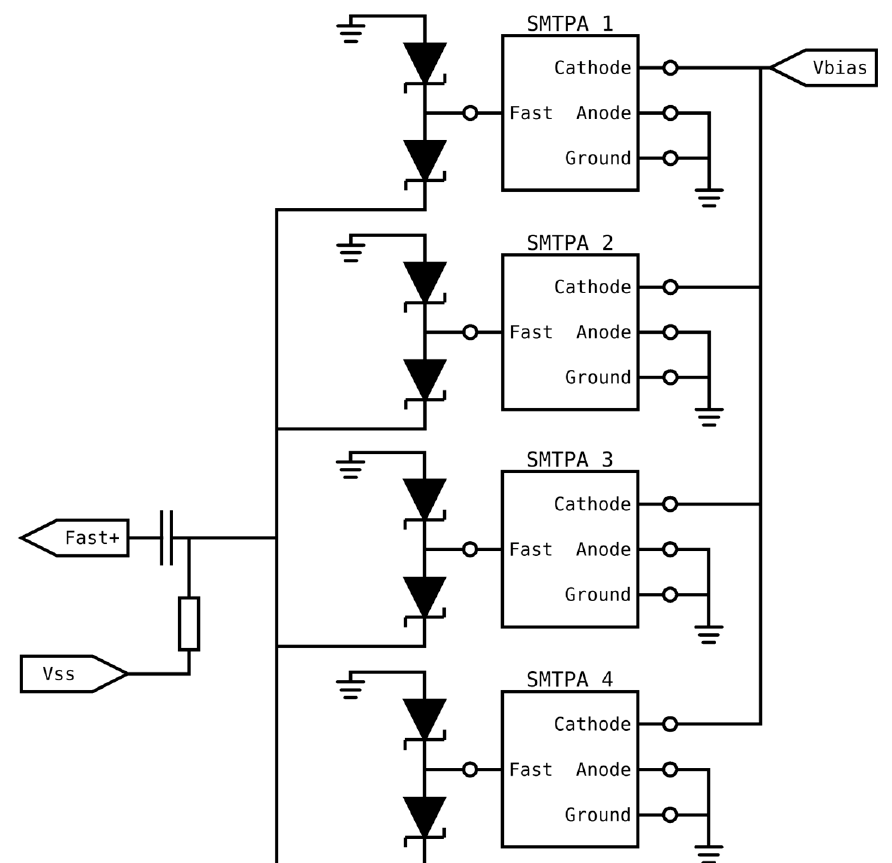
Figure 9. Schematic showing a method of combining multiple SiPM fast outputs together using diode pairs [27].